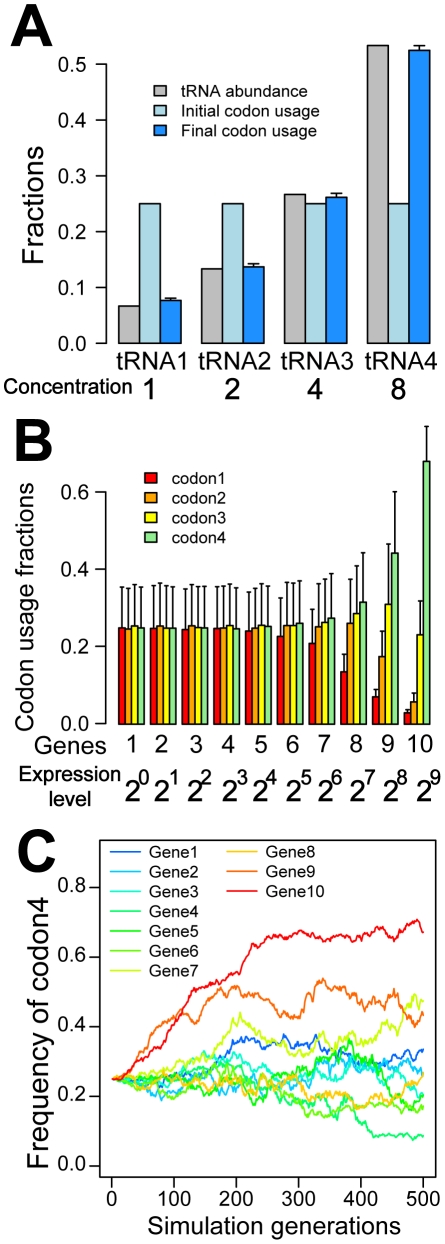
Computer simulation demonstrates that selection for translational efficiency results in the preferential use of codons with abundant cognate tRNAs in highly expressed genes.Ten genes with different expression levels are considered for a haploid organism. Four synonymous codons of an amino acid are each recognized by its cognate tRNA. Concentrations of the four tRNAs differ, but the initial codon frequencies are equal. Synonymous mutations, genetic drift, and natural selection for translational efficiency are considered (see Materials and Methods). (A) Overall changes of transcriptomic codon usage averaged from 1000 simulation replications. Error bars show one standard deviation. (B) Highly expressed genes evolved stronger codon usage biases than lowly expressed genes. The averages from 1000 simulation replications are presented. Error bars show one standard deviation. (C) Evolutionary changes in the usage of codon4, the codon recognized by the most abundant tRNA, in a randomly chosen simulation replication.